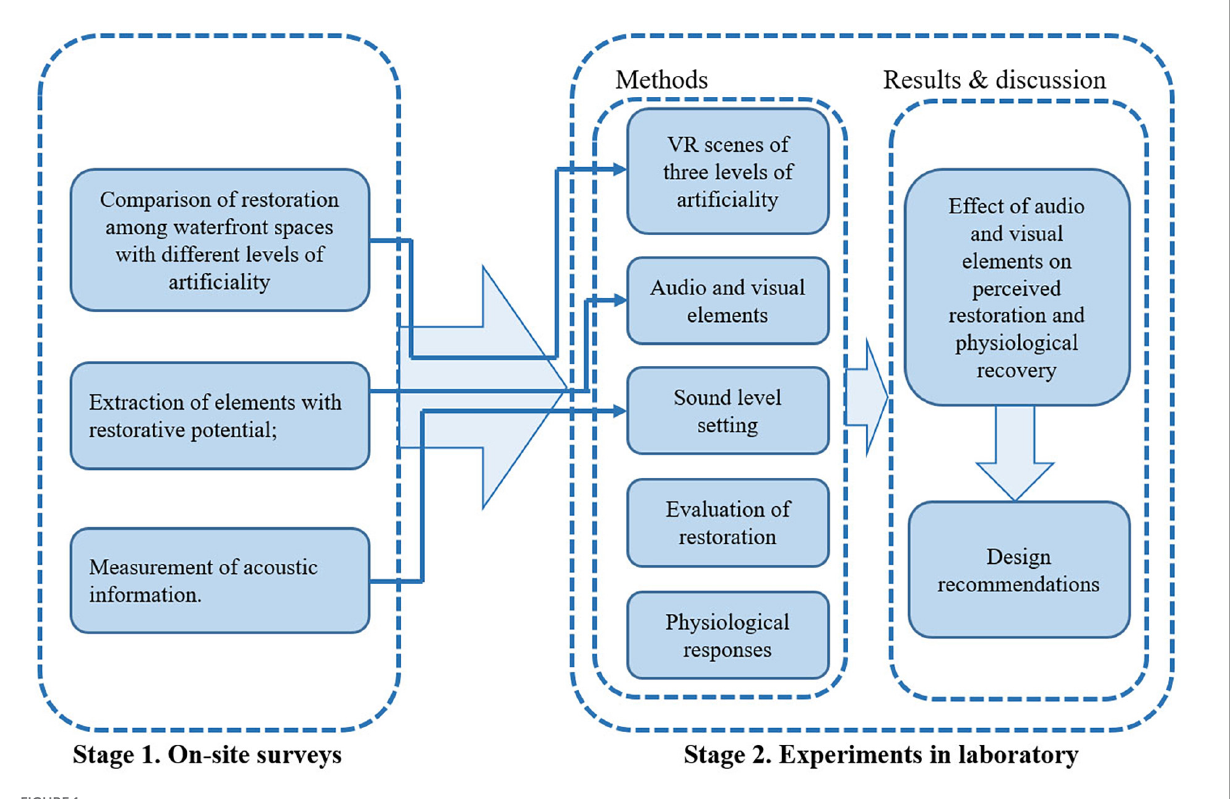
FIGURE1 Workflow: Relationship of survey and experiment phases in this study.